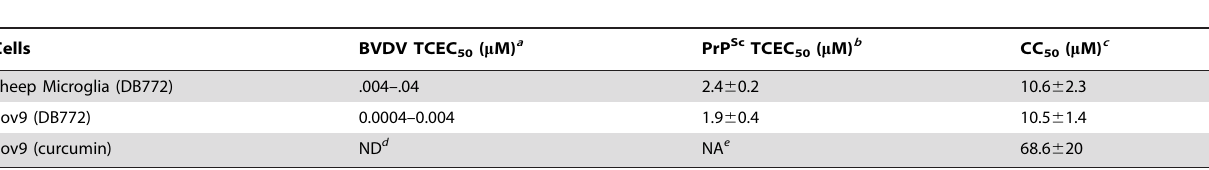
a 50% tissue culture effective concentration (TCEC 50 ). Values are the range in one independent experiment; two additional independent experiments confirmed the value was less than .4 m M. b Values are the mean 6 one standard deviation of three independent experiments. c 50% cytotoxic concentration (CC 50 ). Values are the